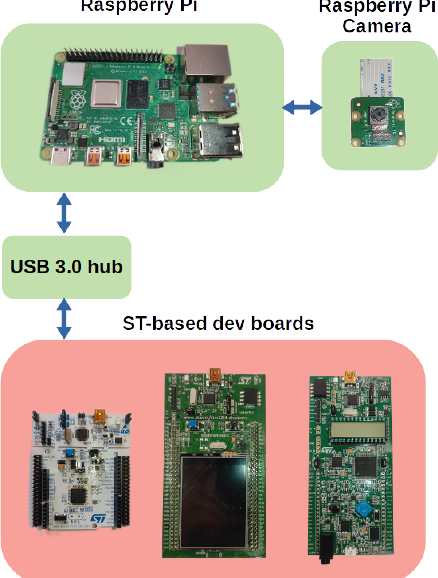
Figure 2. RemoteLab hardware